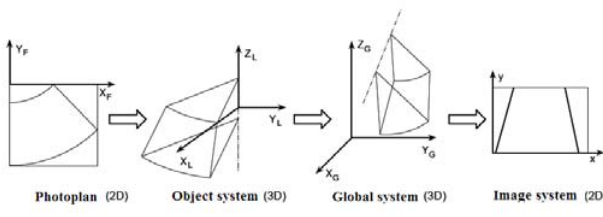
Figure 8. Inverse mapping procedure by cone